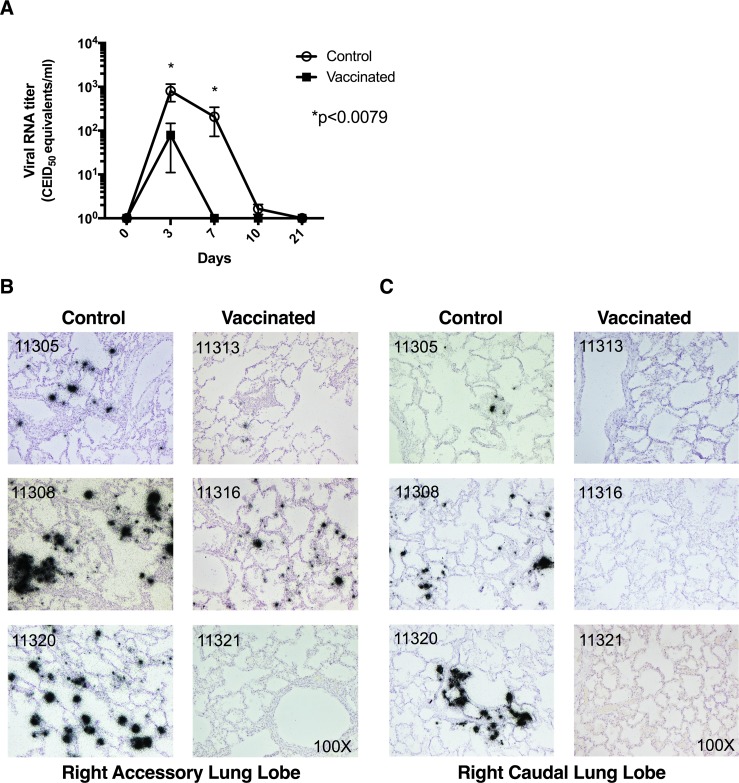
Vaccinated macaques have reduced viral RNA loads and viral replication in nasal washes and lungs.Three weeks post final vaccination (week 15) control and vaccinated macaques are challenged with 107.4 PFU of A/California/04/2009 virus (n = 8/group). A) Bronchioalveolar lavage (BAL) viral RNA titers in control and vaccinated macaques (p<0.0079, Mann-Whitney U test). In situ hybridization with influenza virus specific, 35S-labeled riboprobes was used to localize challenge virus RNAs in the B) right accessory and C) right caudal lung lobes of control and vaccinated macaques at day 3 post infection (n = 3/group). Viral RNA signals are evident as collections of black silver grains over cells. Animal numbers are noted in the upper portion of each micrograph.